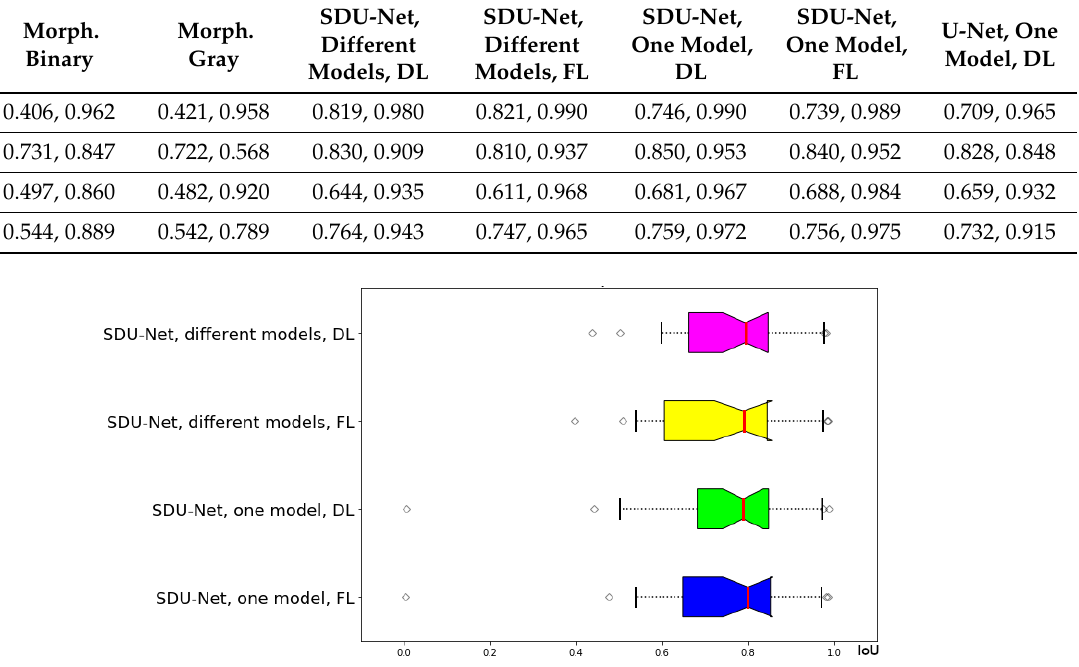
Figure 4. Comparison of the IoU of the classes process light, cool down, and spatter for the different loss functions dice coefficient loss and focal loss, as well as the approach with three different models and one model for all data.